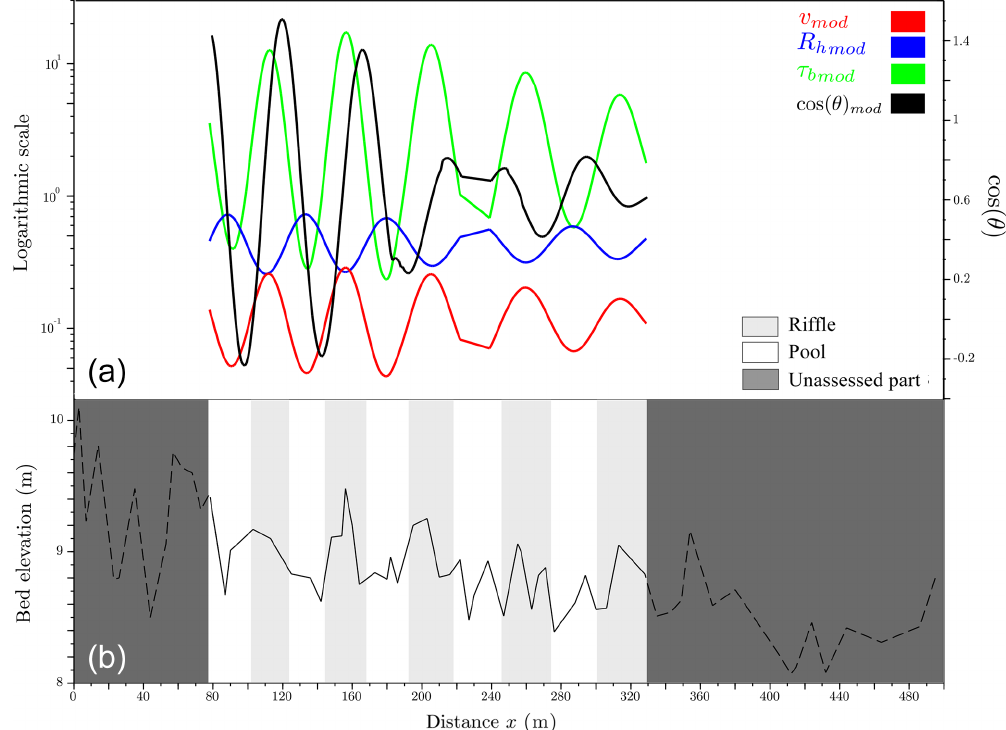
Figure 9. (a) Correlation between the modeled functions f i, mod , which represents the pseudo-periodic variables (velocity in red, hydraulic radius in blue, bed shear stress in green, and local channel direction angle in black) of the Olivet River. These pseudo-periodic functions result in the identification of pools (white) and riffles (gray) in panel (b) . Table 3. The assessed length provided by the wavelet analysis for all reaches in the univariate case using the velocity, hydraulic radius, bed shear stress, or local channel direction angle and in the multivariate case using all these four variables. Reaches Reach Assessed length (cid:96) (m) (univariate) Assessed length length Velocity Hydraulic Bed